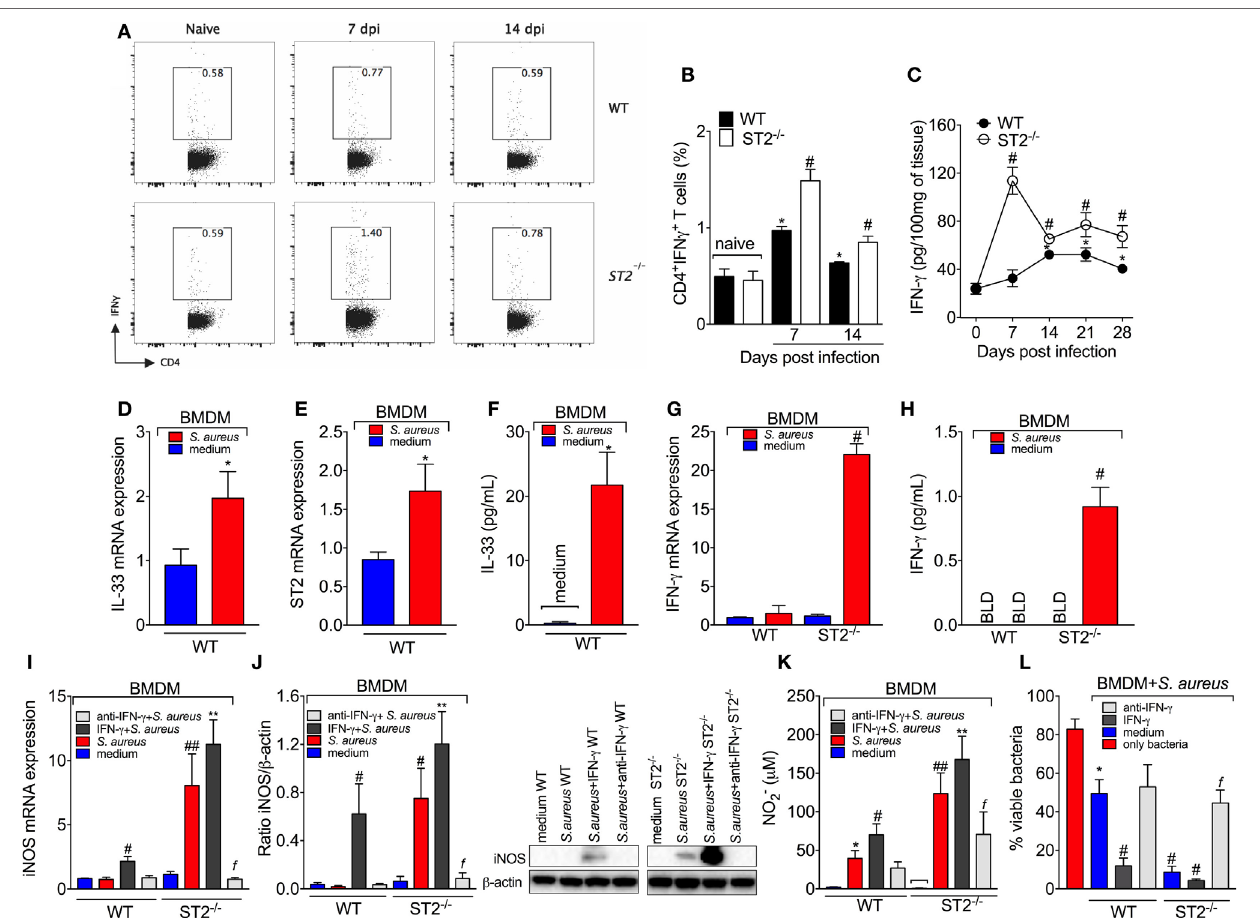
FigUre 5 | ST2 deficiency enhances type 1-driven immune response against Staphylococcus aureus in septic arthritis S. aureus or saline was injected in in the femur-tibial joint of wild-type (WT) and ST2 − / − mice. (a) Representative FACS plots and (B) the percentage of interferon- γ (IFN- γ )-producing CD4 + T cells (CD4 + IFN γ + T cells) from lymph node collected at day 7 and 14 post-infection and evaluated by flow cytometry, and (c) IFN- γ concentrations in the knee joints of WT and ST2 − / − at 7–28 days post-infection determined by ELISA. bone marrow-derived macrophages (BMDMs) (1 × 10 6 ) from naïve WT mice were incubated in vitro with S. aureus at a multiplicity of infection (MOI) of 3 for 18 h to assess: (D) interleukin-33 (IL-33) mRNA and (e) ST2 mRNA expression by qPCR, (F) IL-33 levels by ELISA. BMDMs (1 × 10 6 ) from naïve WT and ST2 − / − mice incubated in vitro with S. aureus at a MOI of 3 for 18 h to assess: (g) IFN- γ mRNA expression by qPCR and (h)